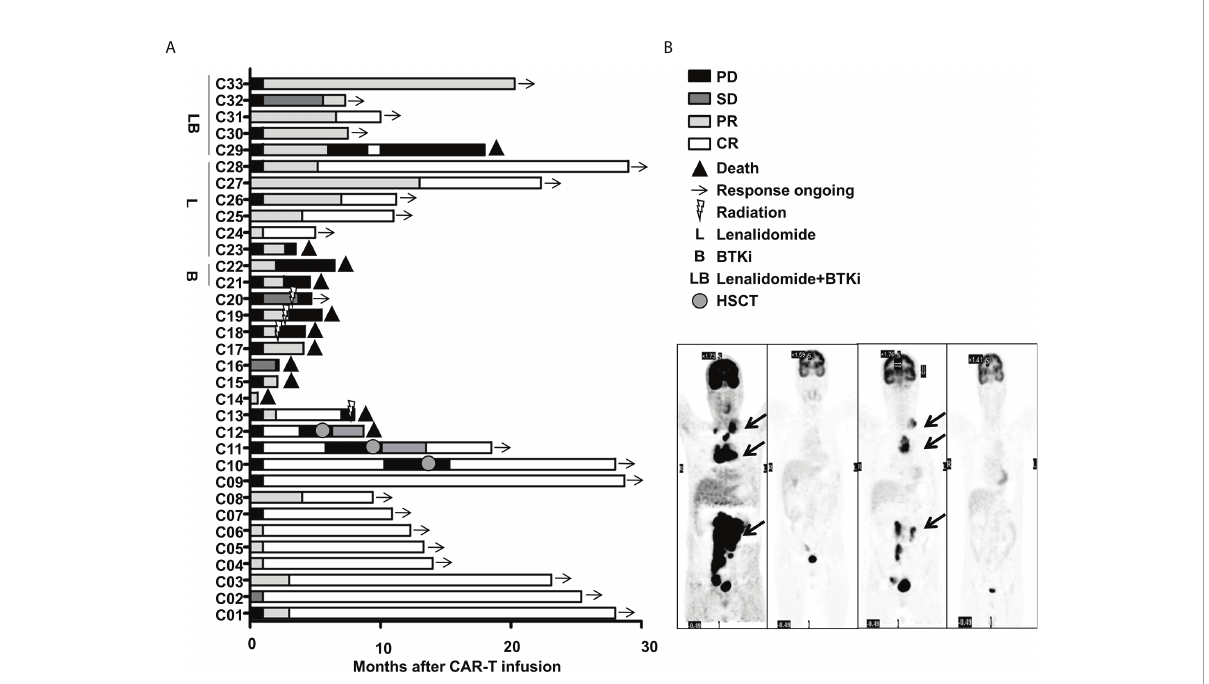
FIGURE 2 Clinical ef fi cacy after CAR-T therapy in 33 R/R DLBCL patients. (A) Duration of response and survival post-infusion with CAR-T cells in all patients. (B) Representative PET-CT before CAR-T infusion, 1 month after CAR-T infusion, before HSCT and 3 months after HSCT in patient C10 was shown. The black arrow points to the location of the tumor.